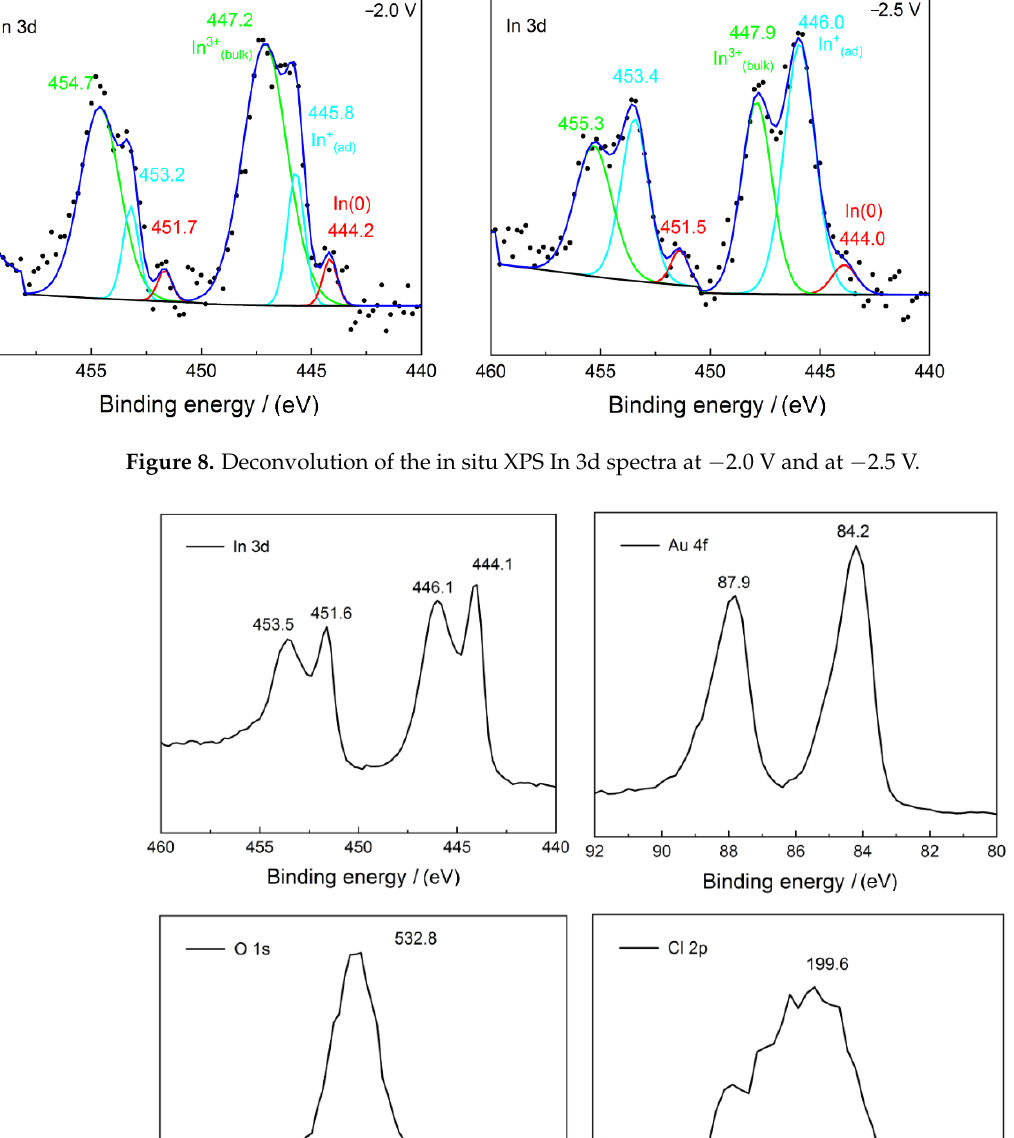
Figure 8. Deconvolution of the in situ XPS In 3d spectra at − 2.0 V and at − 2.5 V.